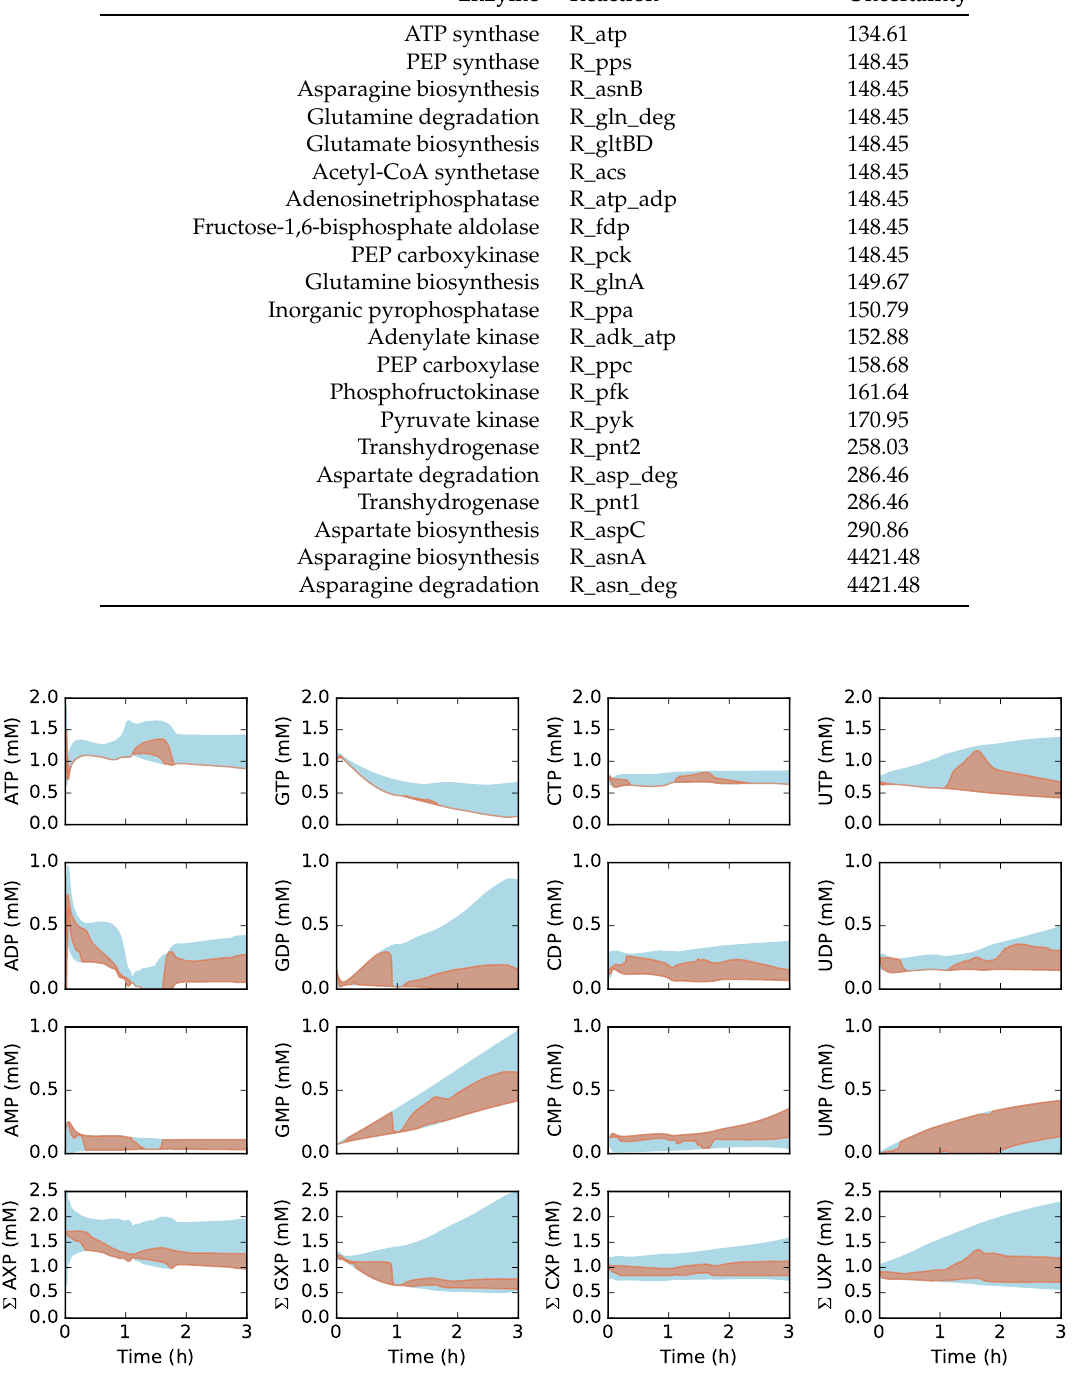
Figure 4. Simulation of energy species and energy totals by base versus synthetic data as a function of time. The 95% confidence interval for the simulation conducted over the ensemble of transcription/translation parameter sets is shown in the orange shaded region, while the synthetic constraint data is shown in the blue shaded region. The synthetic data constraints were generated from the kinetic model of Horvath et al., which was trained using experimental measurements of the system simulated in this study